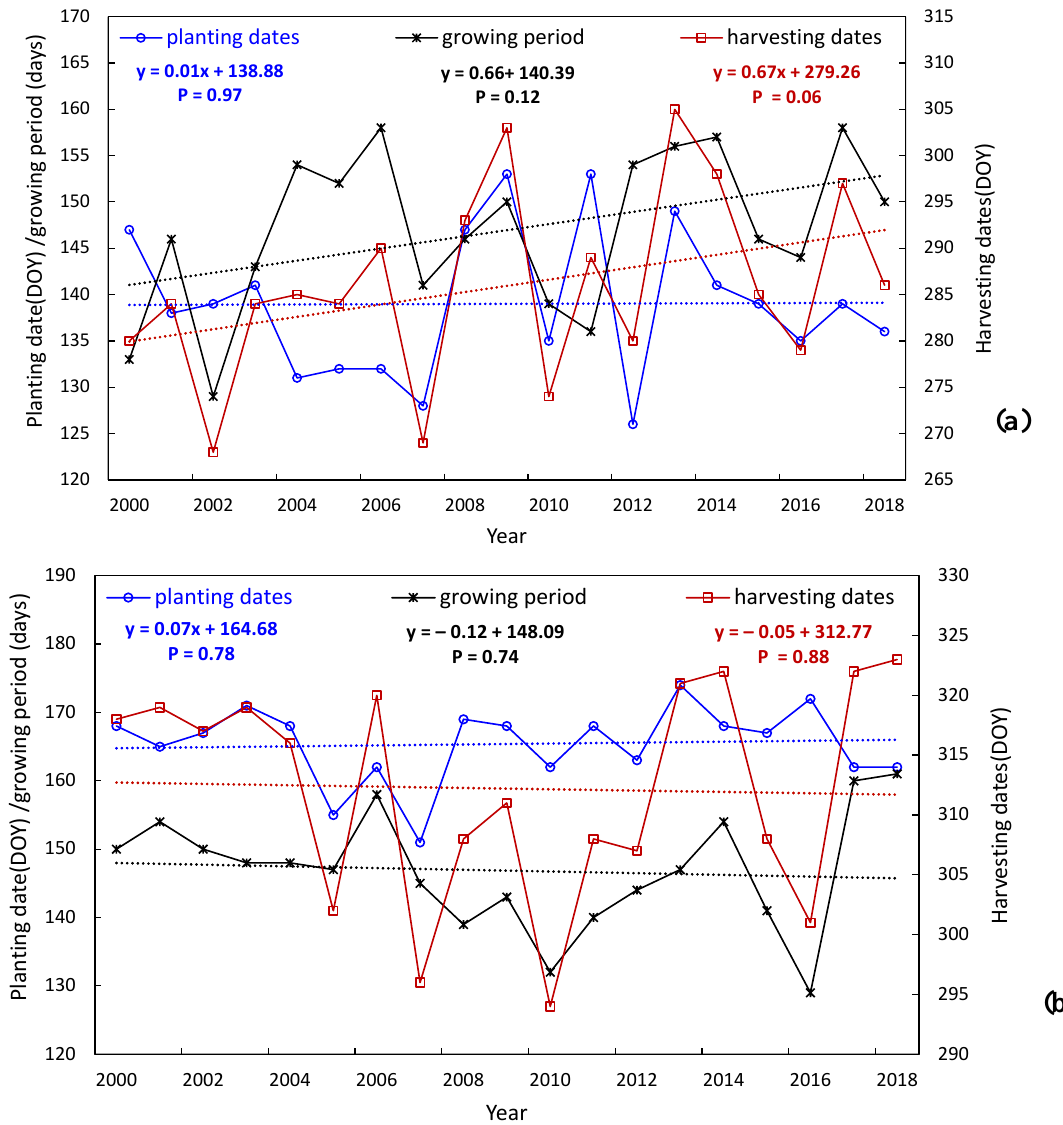
Figure 7. Linear regression analysis for trends of phenological stages in Kentucky, 2000–2018 (( a ) corn, ( b ) soybean).